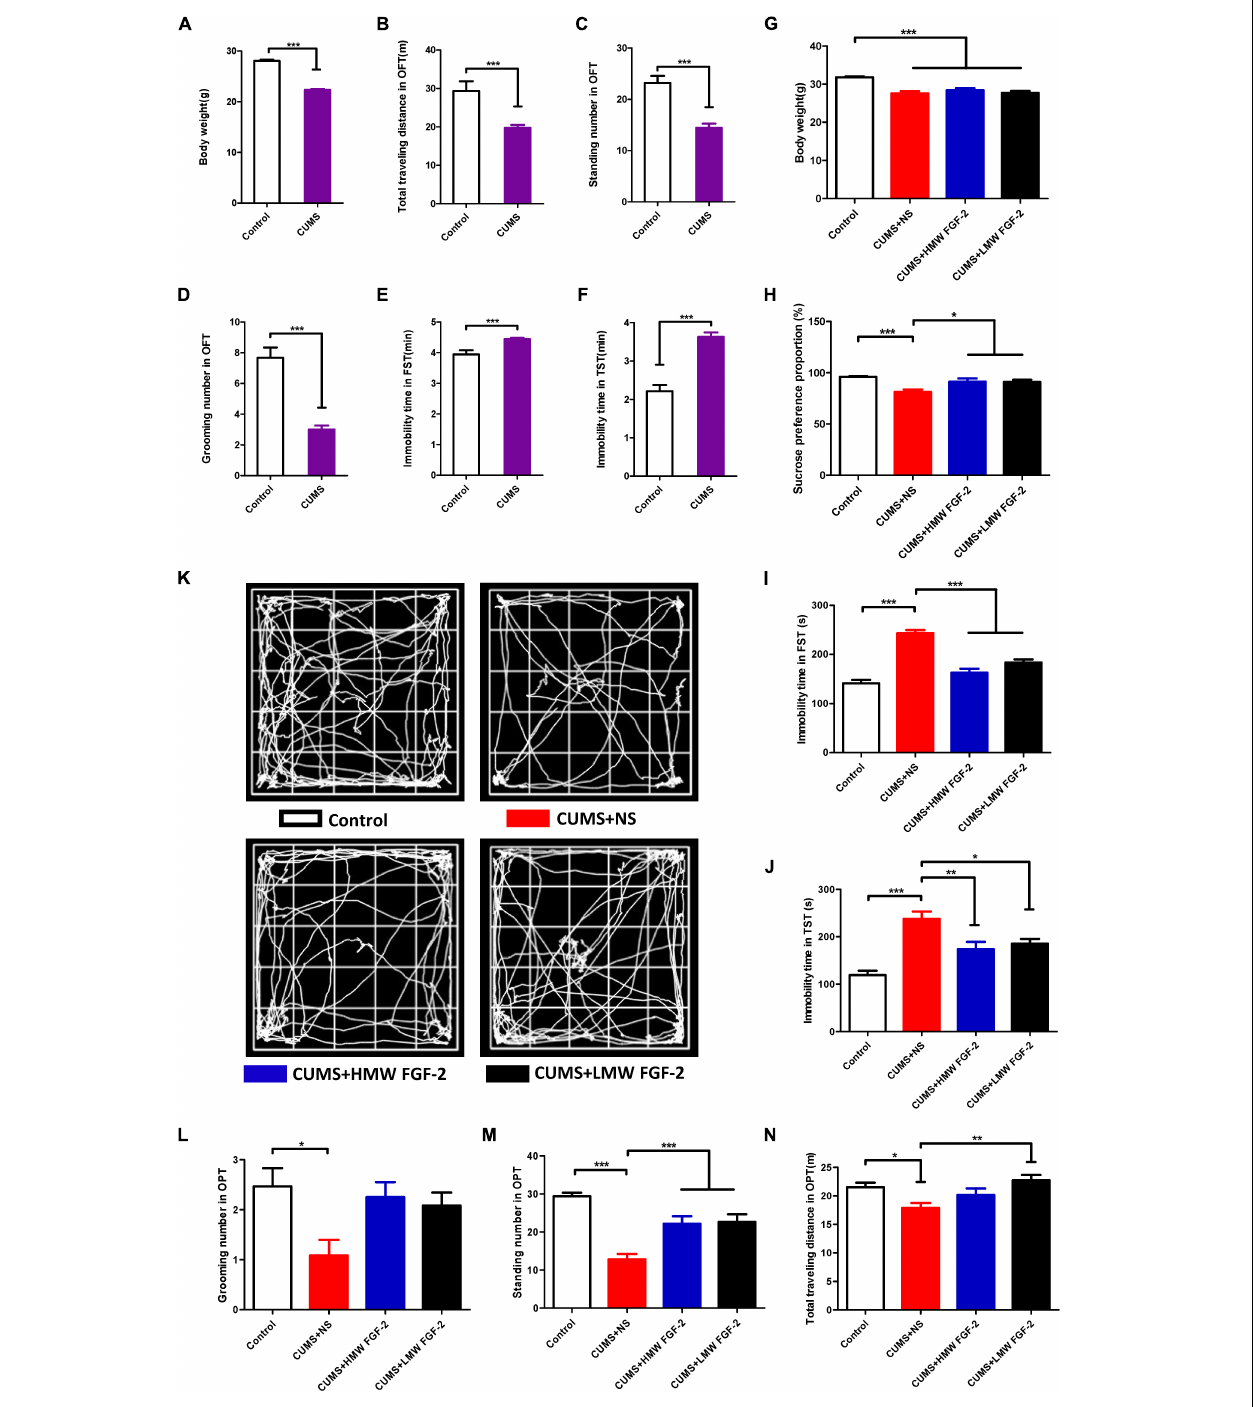
FIGURE 2 | Chronic unpredictable mild stress (CUMS) leads to depression-like behaviors in mice, and FGF-2 reverses these behaviors. (A–F) Behavioral tests showing that performing CUMS procedures for 45 days can lead to depression. (G) All stressed mice showed markedly lower body weight treated with or without FGF-2. (H) Mice in the CUMS+HMW FGF-2 and CUMS+LMW FGF-2 groups displayed increased sucrose preference. (I) Mice in the CUMS+HMW FGF-2 and CUMS+LMW FGF-2 groups showed significantly increased forced swimming immobility time and (J) significantly increased tail suspension immobility time. (K) Trace plot of the open-field test after FGF-2 administration. (L) Open-field test showing the pathological behavior of animals. No significant differences in the grooming numbers were observed in the drug treatment groups. (M) The standing numbers were significantly increased by HMW FGF-2 and LMW FGF-2 treatment, (N) the total distance traveled by CUMS mice was significantly increased by treatment with LMW FGF-2. Results are expressed as the mean ± SEM, (A–F) , t -tests; (G–J, L–N) , one-way ANOVA with Tukey’s post hoc test, n = 15, 12, ∗ p < 0.05, ∗∗ p < 0.01, and ∗∗∗ p < 0.001.